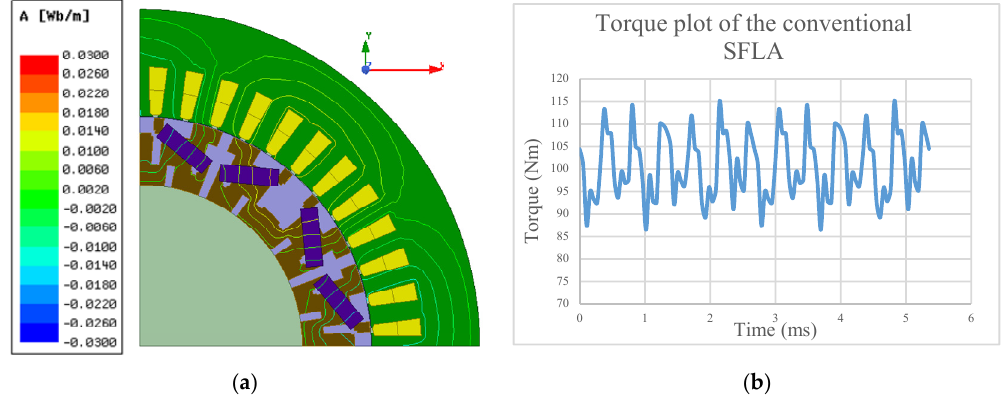
Figure 4. The Optimized design of IPM obtained by the conventional SFLA: ( a ) cross-section; and ( b ) torque plot.